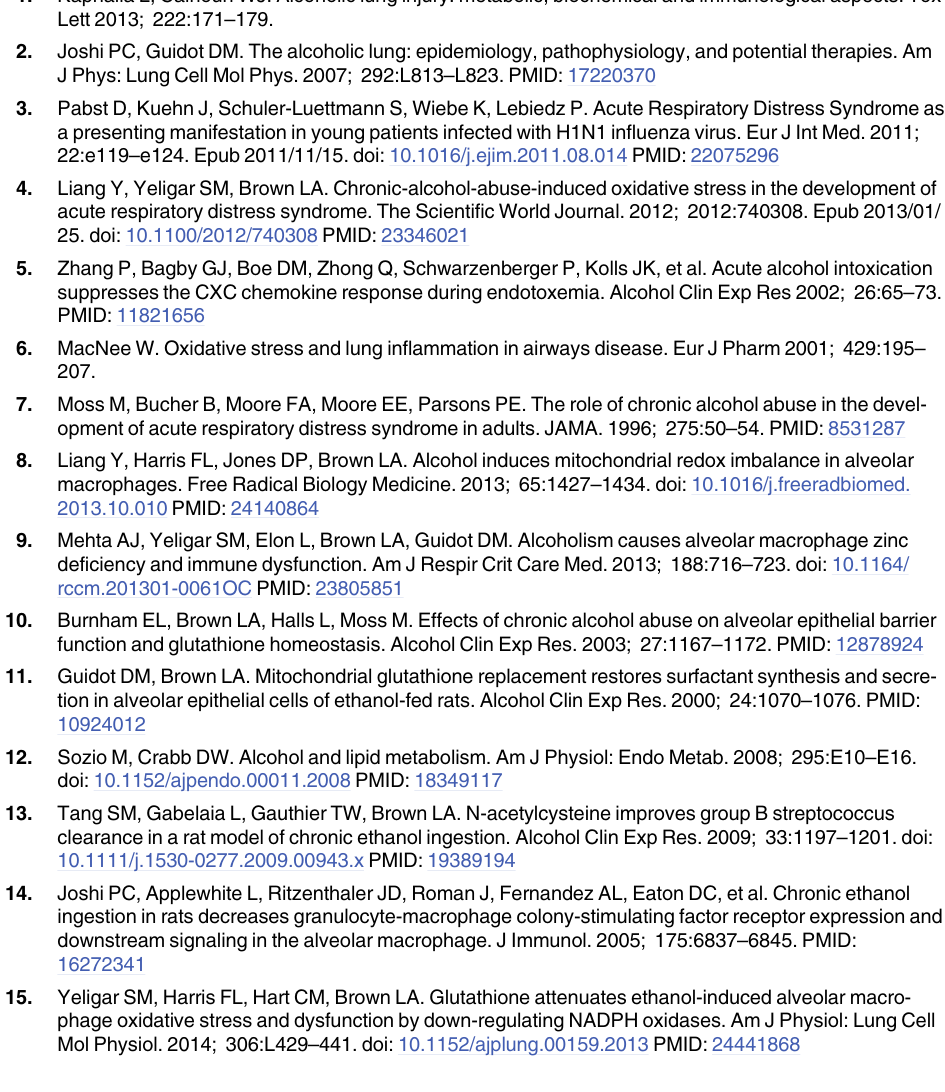
S1 Table. Metabolomics Dataset. Data containing the m/z and retention times are presented in an Excel spreadsheet. Samples were ran in triplicate. Samples for the 10 nonsmoking AUD subjects are designated “ E ” and the 10 nonsmoking controls as “ N ”